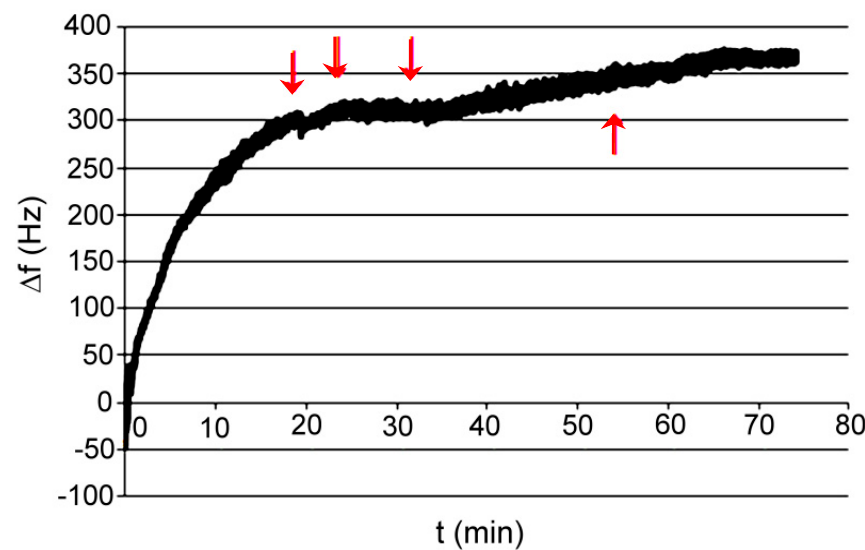
Figure 16. Changes of frequency in time for XVII polymer; absorbed compound—acetylsalicylic acid in acetonitrile.